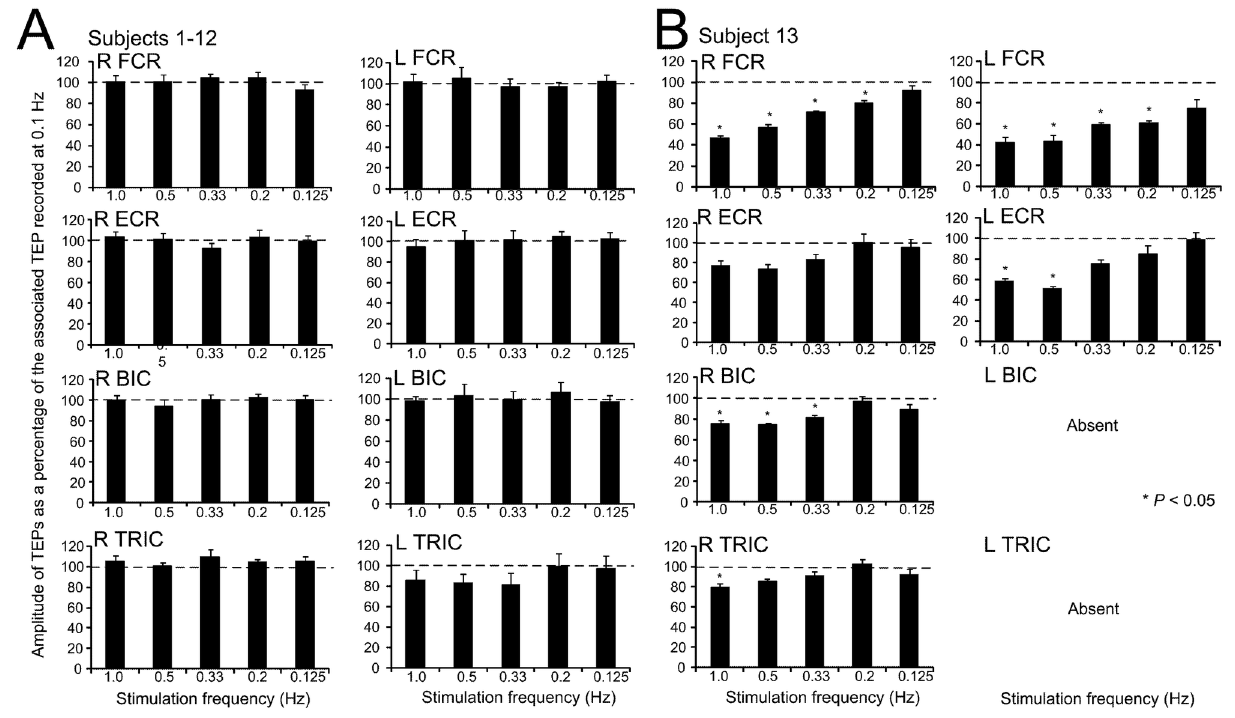
Figure 4. Susceptibility of transpinal evoked potentials (TEPs) to homosynaptic depression. The overall mean amplitude of the TEPs recorded bilaterally from the right (R) and left (L) flexor carpi radialis (FCR), extensor carpi radialis (ECR), biceps brachii (BIC), and triceps brachii (TRIC) muscles for subjects 1-12 (A) and for subject 13 (B). TEPs recorded at 1.0, 0.5, 0.33, 0.2, and 0.125 Hz are presented as a percentage of the mean amplitude of the associated TEPs recorded at 0.1 Hz. Asterisks indicate statistically significant differences from control TEPs values. Error bars represent the